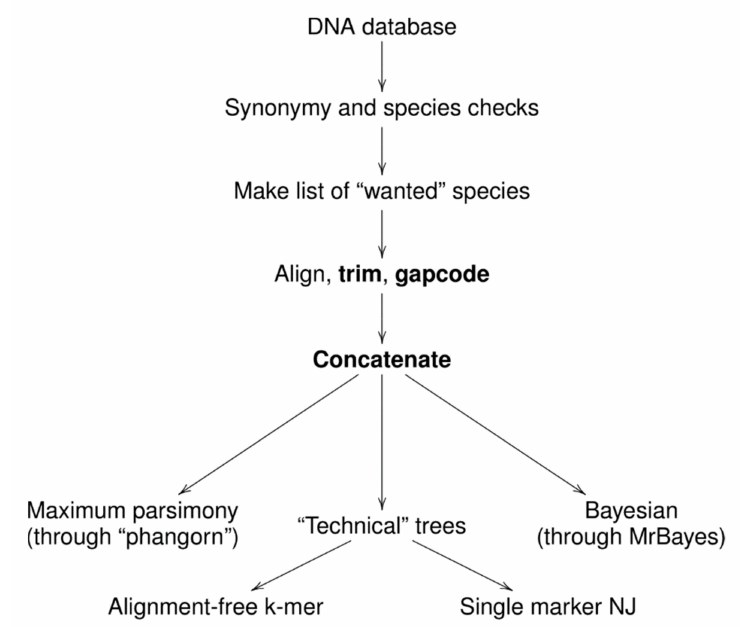
Figure 2. Ripeline: workflow and basic